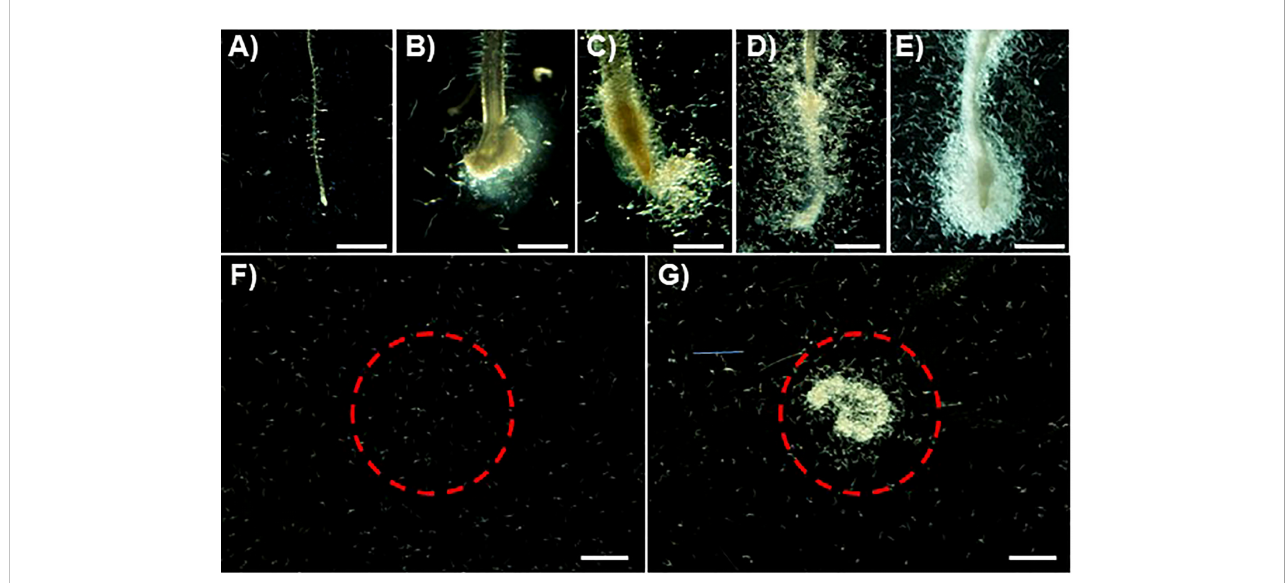
FIGURE 1 SR secretes RKN attractants to the environment. (A – D) Representative RKN behavior in vitro in the presence of Arabidopsis (A) , rice (B) , tomato (C) , L. coniculatus L. (D) roots, and SR (E) . (F, G) Representative images of RKN behavior in vitro in the presence of SR culture media supernatant before (F) and after (G) SR growth. Red circles denote the area where samples were applied. Scale bars = 1